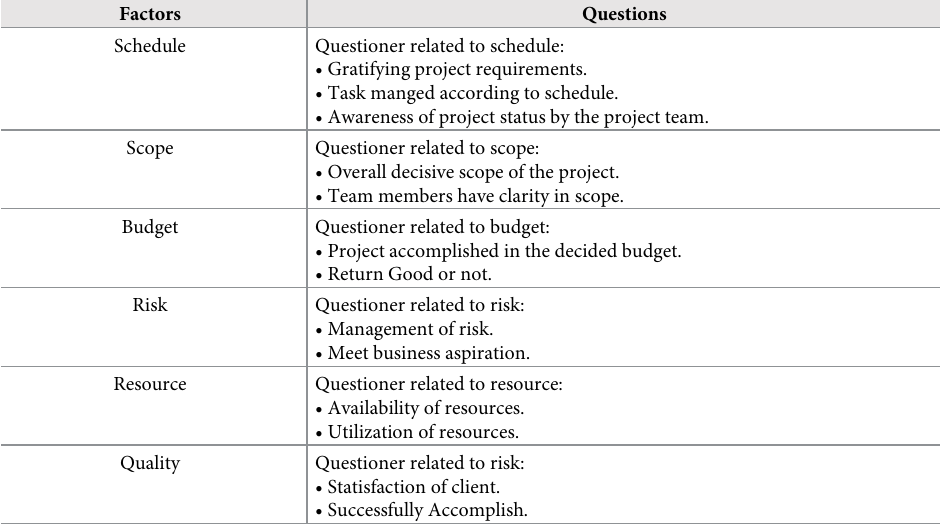
Table 6. Questioner form based on six-pointed star